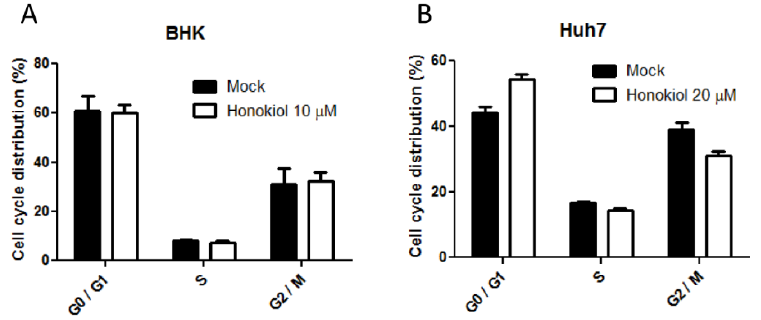
Figure 6. Honokiol induces a slight cell cycle alteration in Huh7 but not BHK cells. ( A ) BHK and, ( B ) Huh7 cells were mock or treated with honokiol for 48 h. The cells were then fixed, stained with PI and analyzed by flow cytomerty. The distribution of cell cycle phases was demonstrated by bar charts. Data indicate the average value of triplicates (mean ± SD).